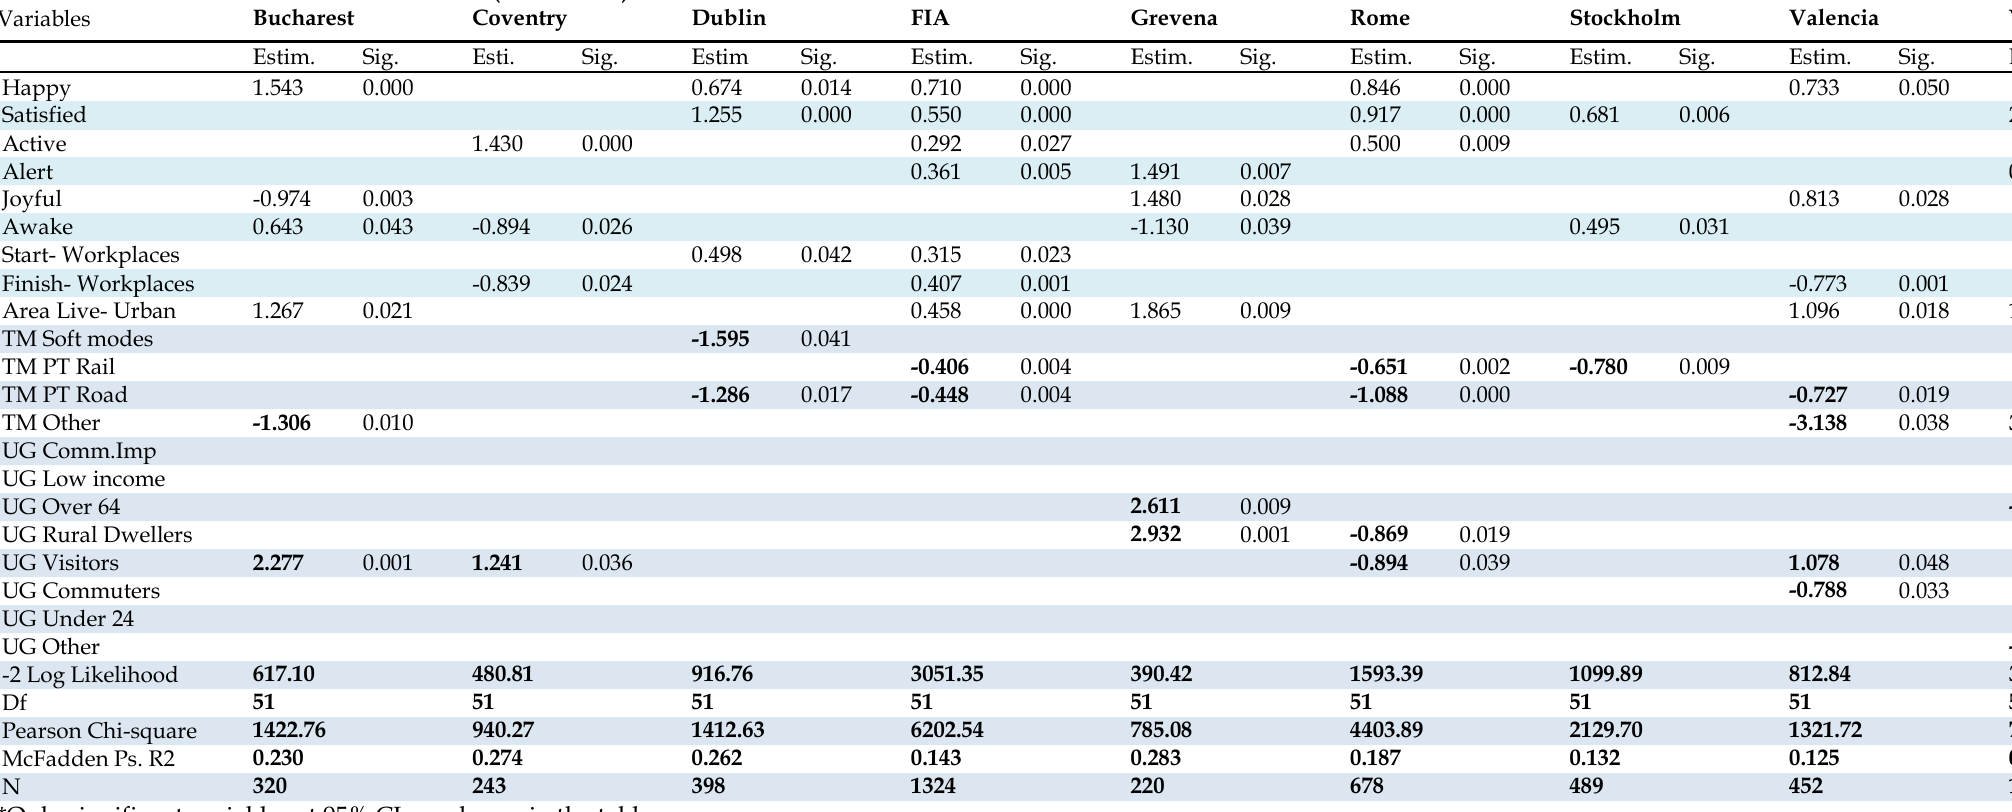
Table 5: Estimation results for M1 model (continued)